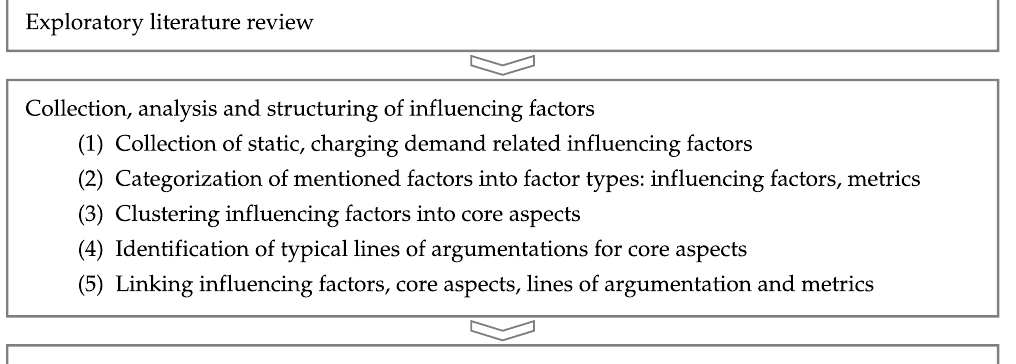
Figure 3. Approach for the static, charging demand related site evaluation